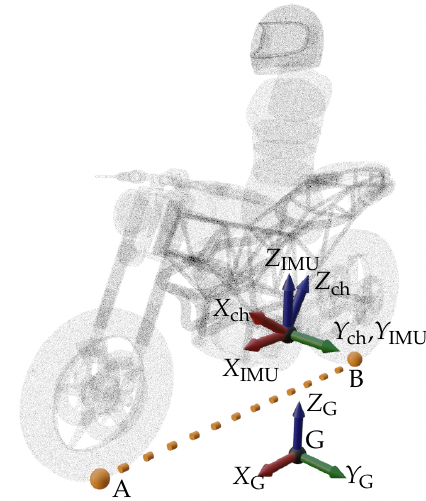
Figure 5. IMU position